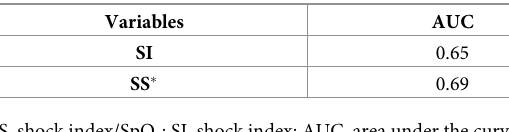
SS, shock index/SpO 2 ; SI, shock index; AUC, area under the curve � Comparision of AUCs: P = 0.001.